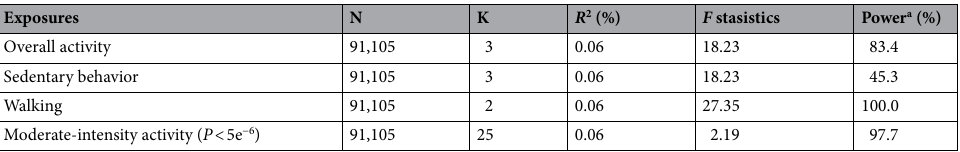
Table 2. Results of F statistic and statistical power for the Mendelian randomization analysis of genetic instruments and the risk of AD. N, sample size; K, number of genetic instruments; R 2 , the proportion of variance in the exposure explained by each genetic instrument. a Statistical power was calculated based on a sample size of 63,926 participants, type I error 1.25% and a ratio of case to control (1 to 1.908).